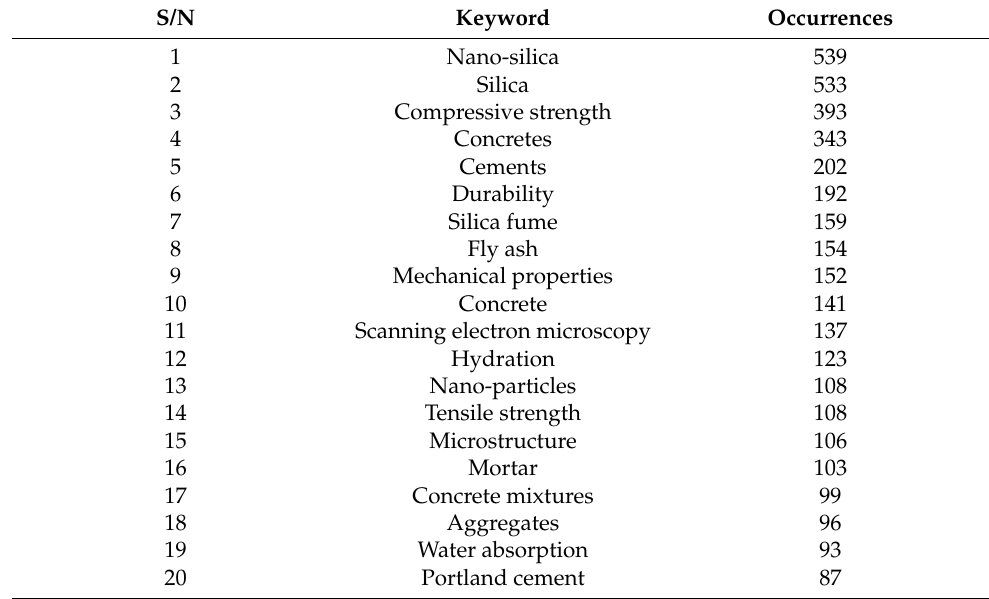
Table 1. List of top 20 frequently used keywords in the research of NS